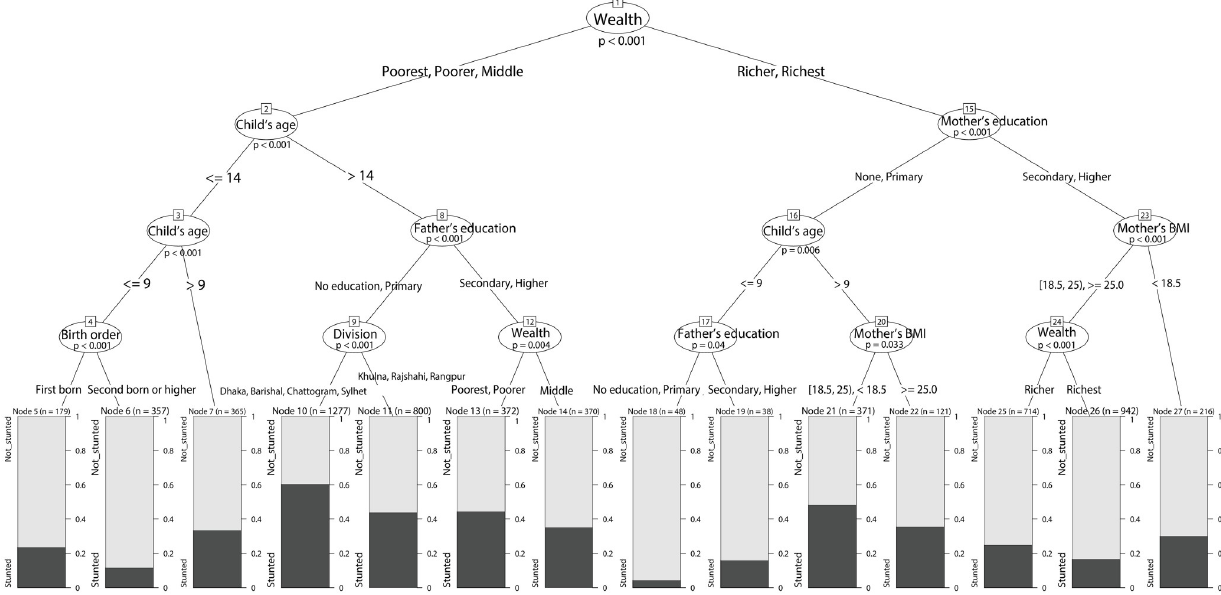
Fig 1. Classification tree for stunting in under-five children in Bangladesh. The value of n at each final node gives the node sample size and the black fill in the box below indicates proportion of stunted children under the node. The p-value at each node corresponds to a unified permutation test of hypothesis indicating independence between the response and predictors